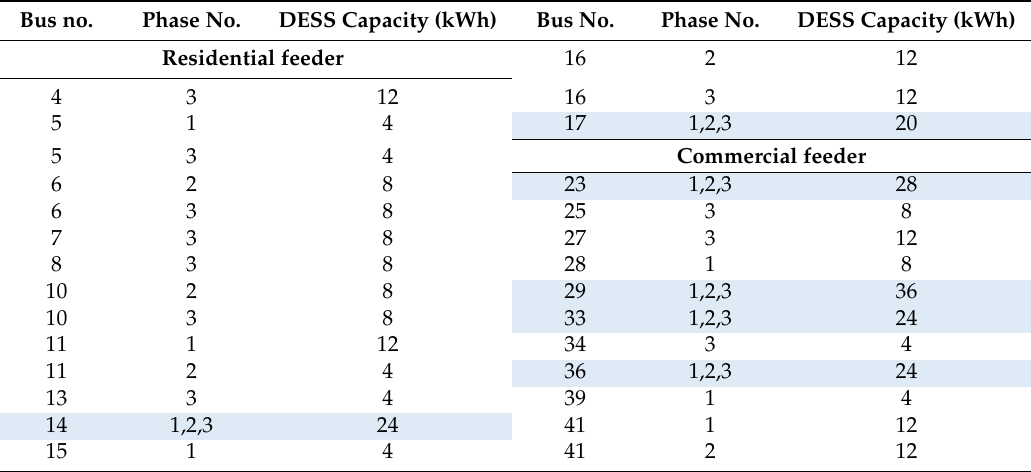
Table 7. Case Study 2: DESS Allocation